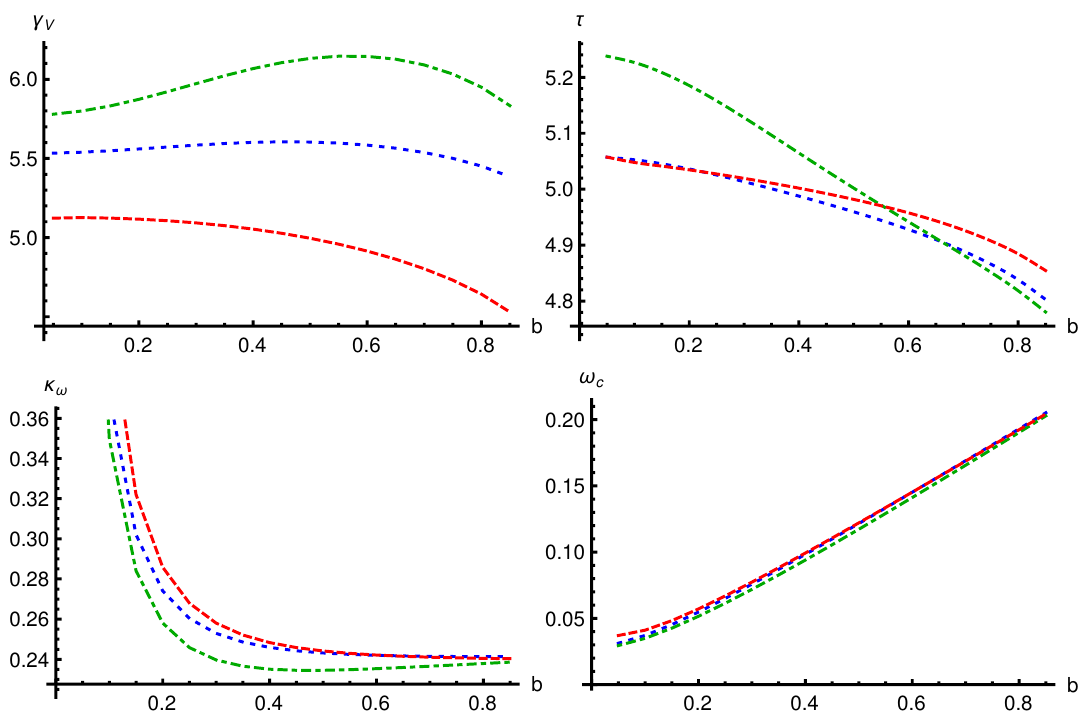
Figure 10 . The fit parameters for averaged optical conductivities of the striped phase as functions of b , for µ = 4 . The dotted blue, dot-dashed green, and dashed red curves are fits to data for h σ xx i , h σ yy i , and h σ xy i , respectively.